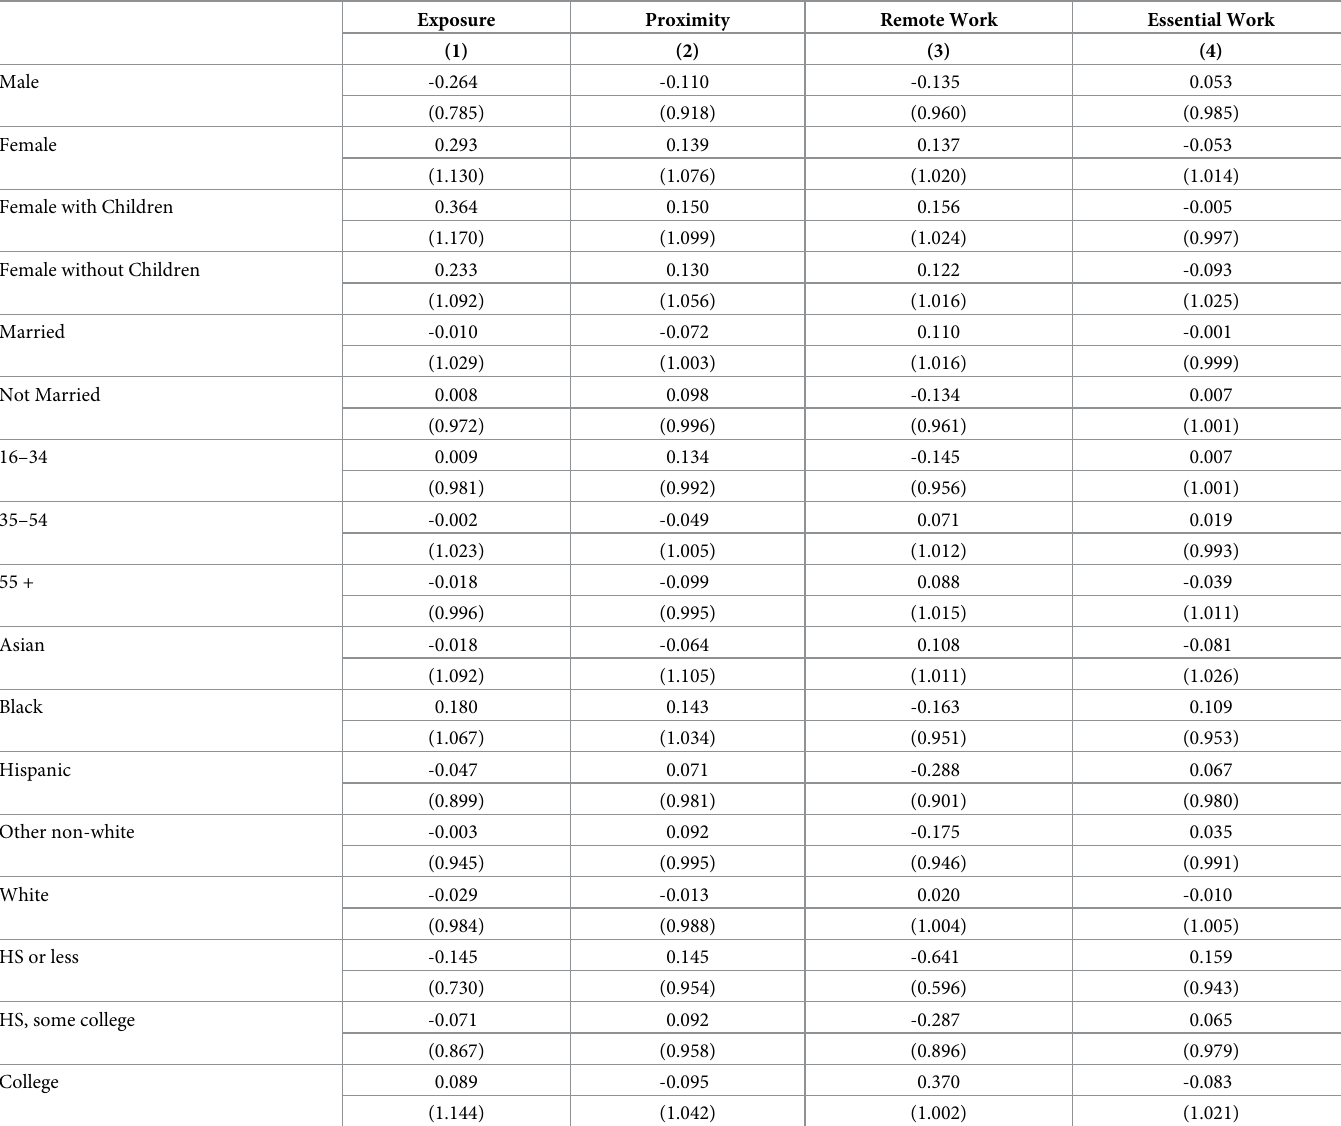
Table 5. Mean index values by socio-economic